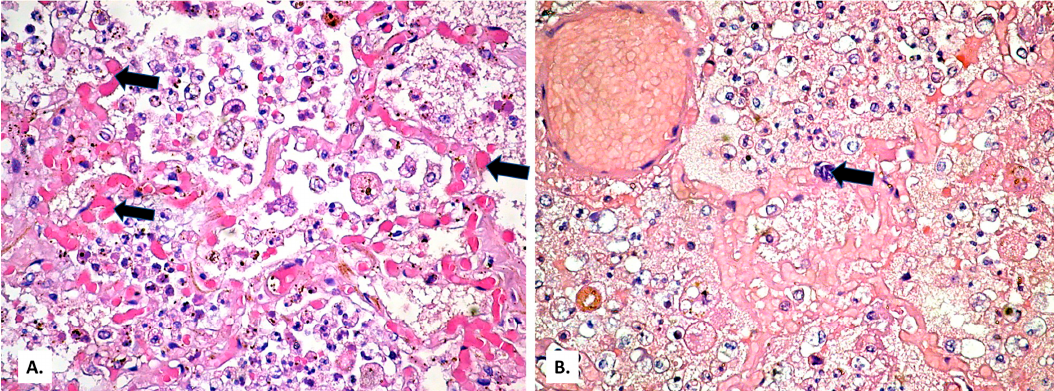
Figure 5. ( A ) Hyaline microthrombi (formed by fibrin) in the alveolar capillaries (arrows). ( B ) Basophilic microthrombus (formed by platelets) in the alveolar capillaries (arrows) (HE × 200).